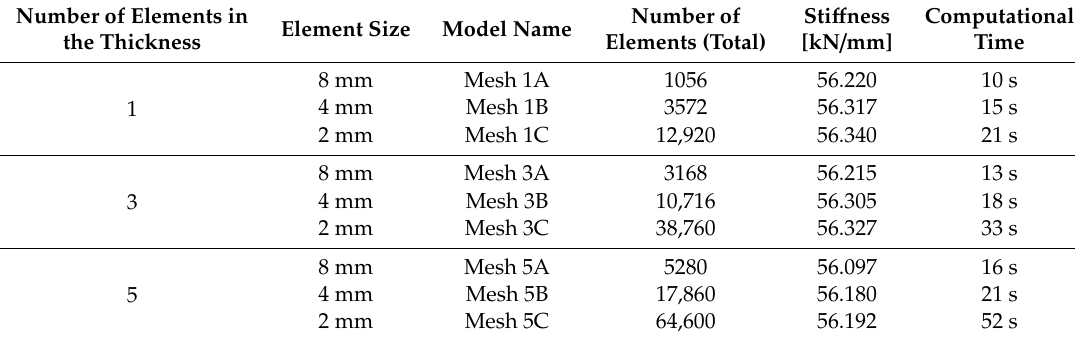
Table 2. Mesh convergence analysis results.